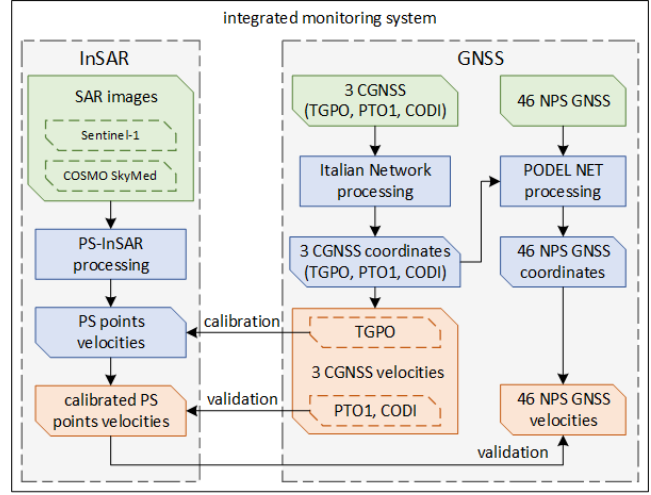
Figure 2. Scheme of the approach proposed in this work to estimate the land subsidence affecting the PRD area.